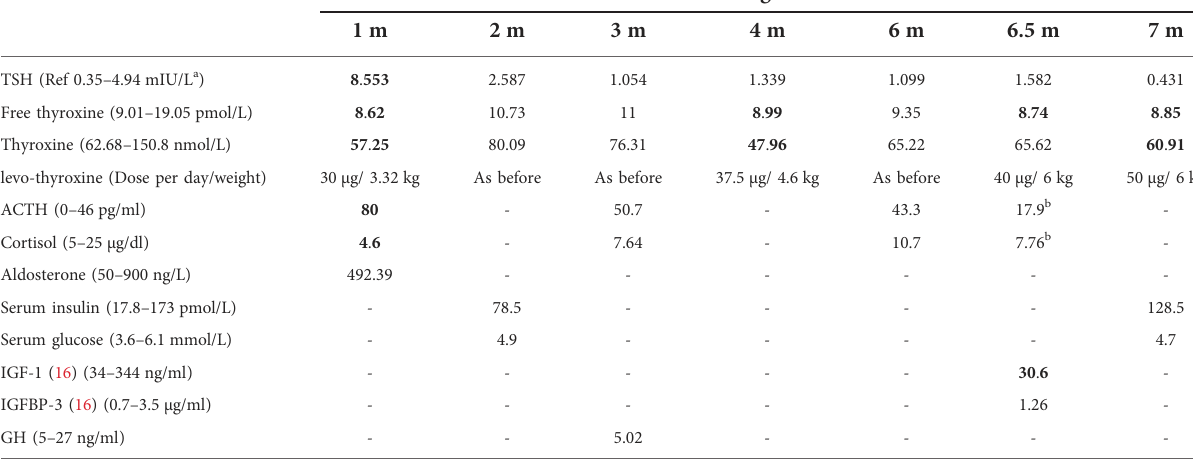
TABLE 1 Brief summary of the patient ’ s hormonal evaluations and drug application.